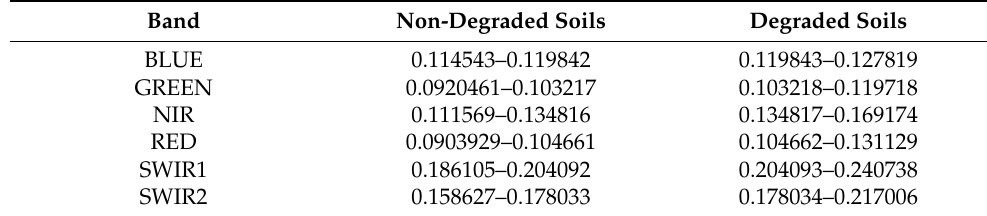
Table 4. Classification of ranges of the Landsat bands mean values according to soil degradation.